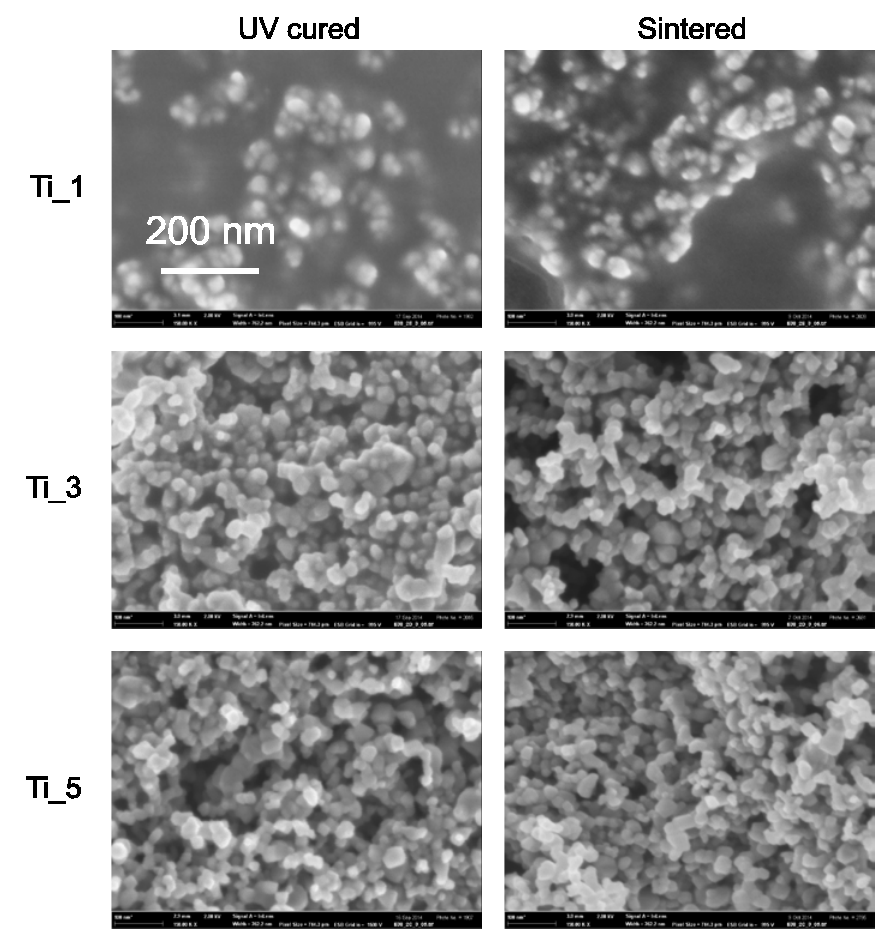
Figure 5. Images from SEM analysis; comparison of UV cured and sintered layers (3 layered